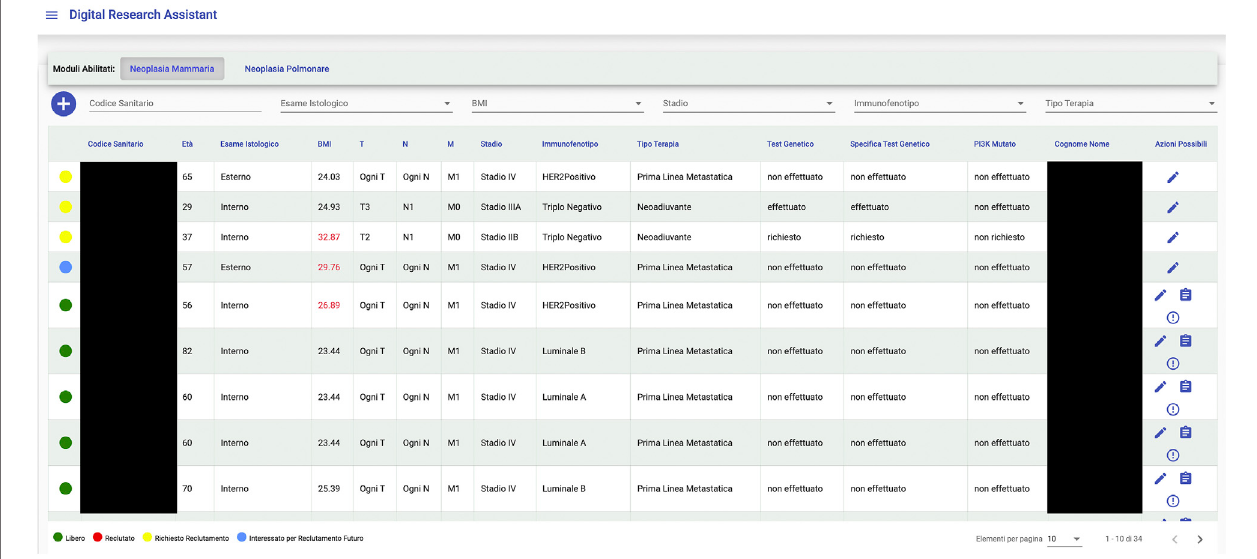
FIGURE 6 | The DIgital research assistant